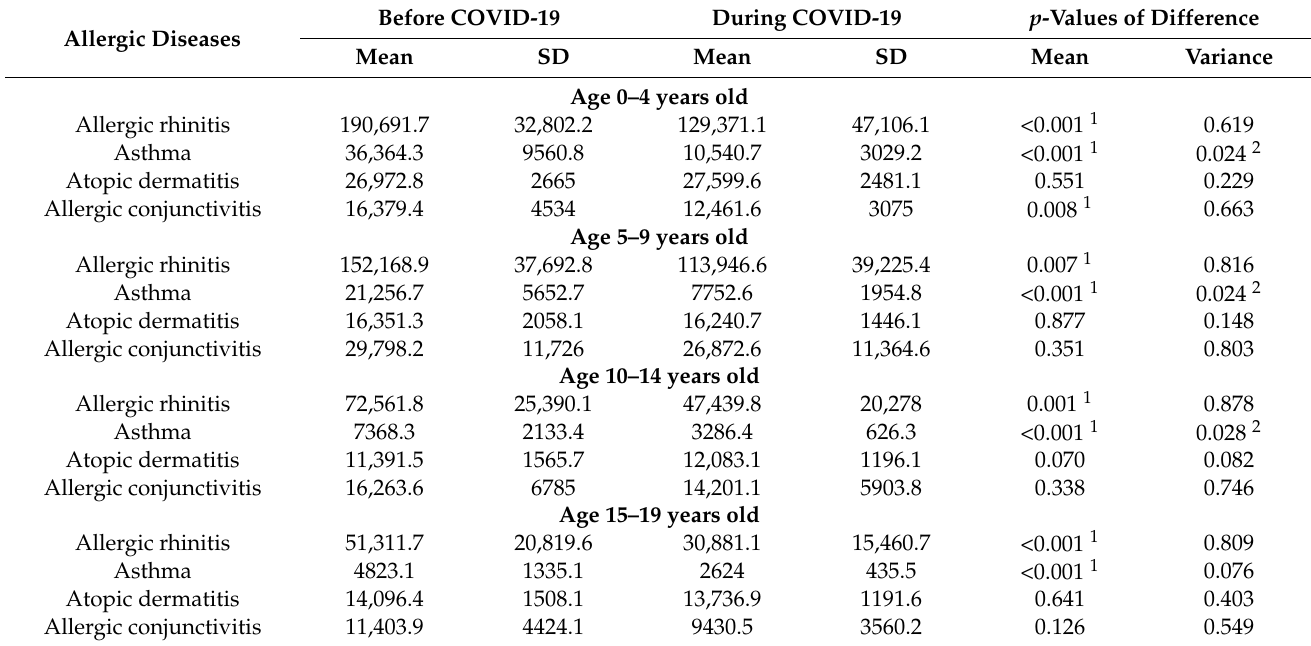
Table 4. Monthly numbers of pediatric patients treated for allergic diseases before and during the COVID-19 pandemic and the differences in the subgroups divided into five-year